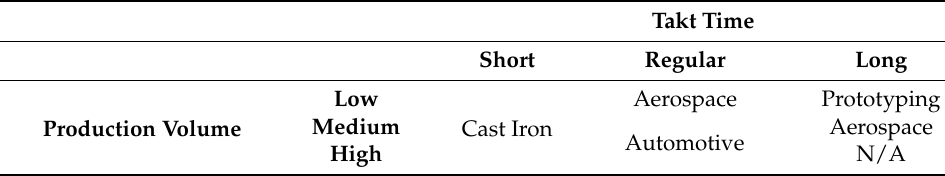
Table 7. Proposed tool material selection